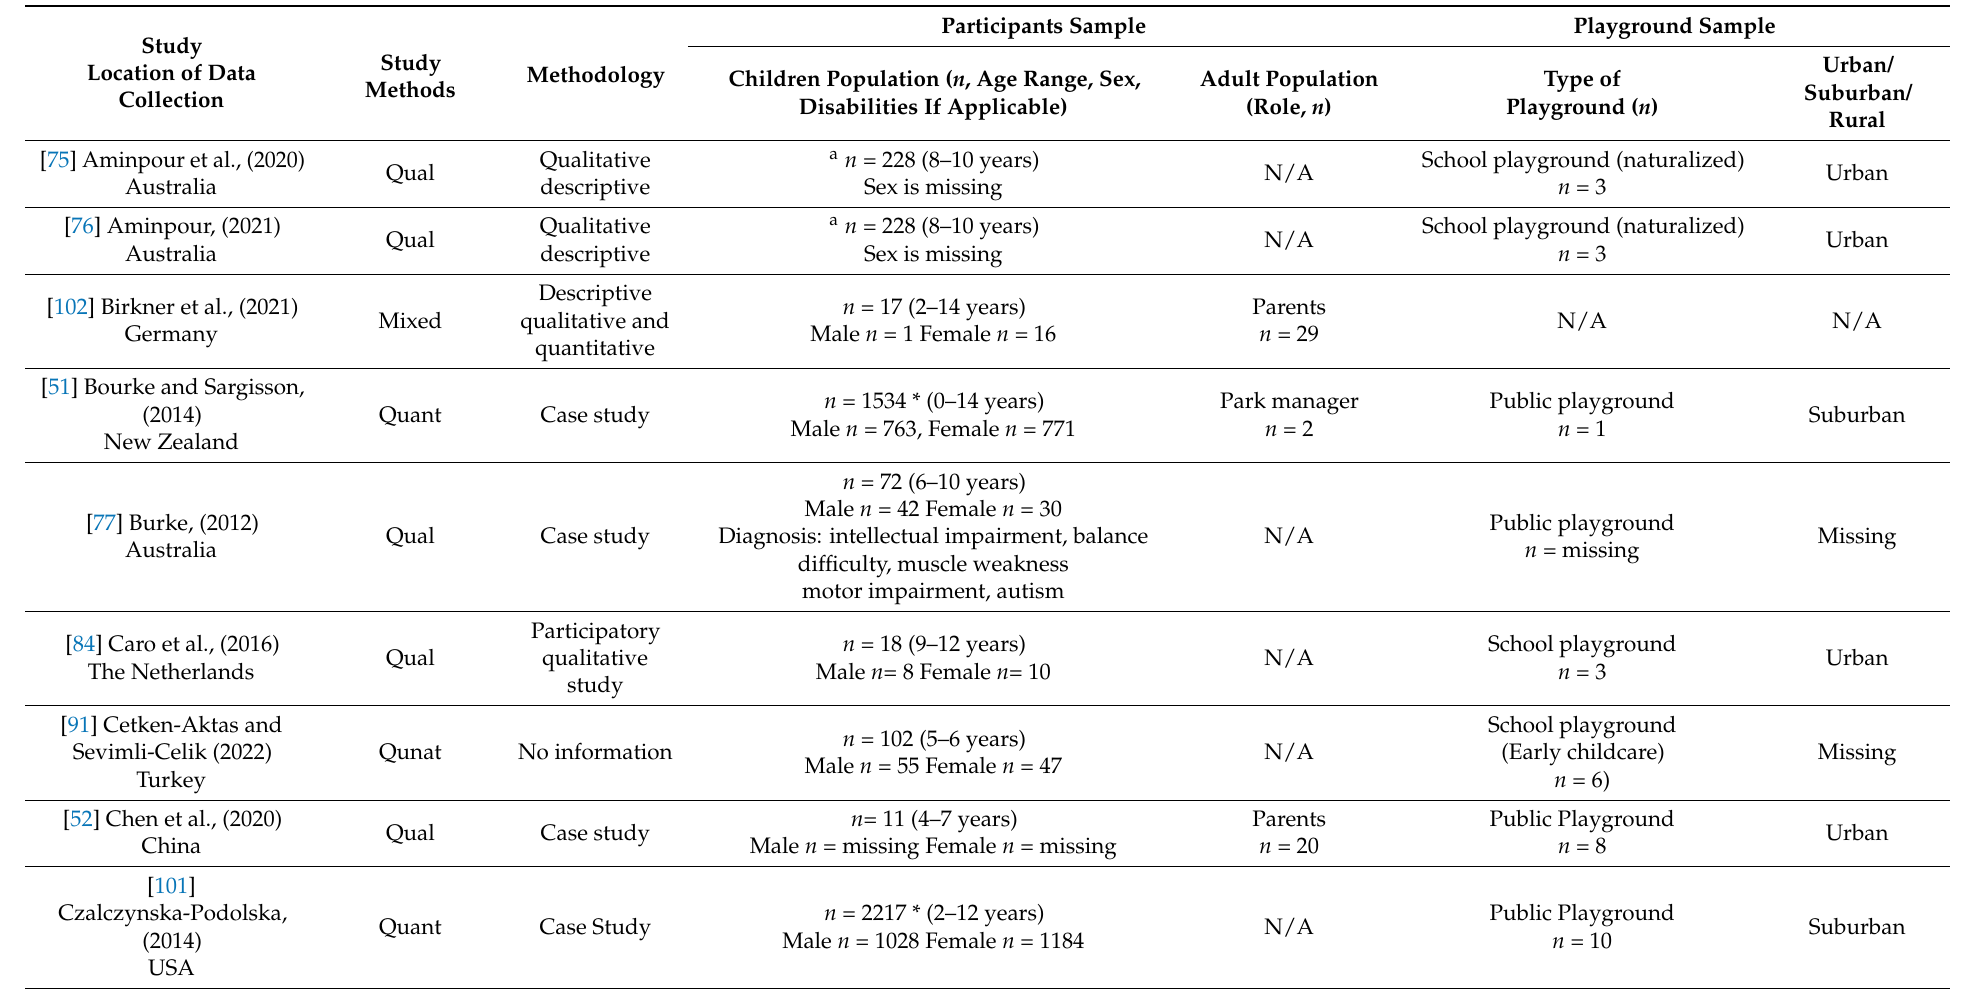
Table A2. Included publication’s characteristics, participants, and playgrounds